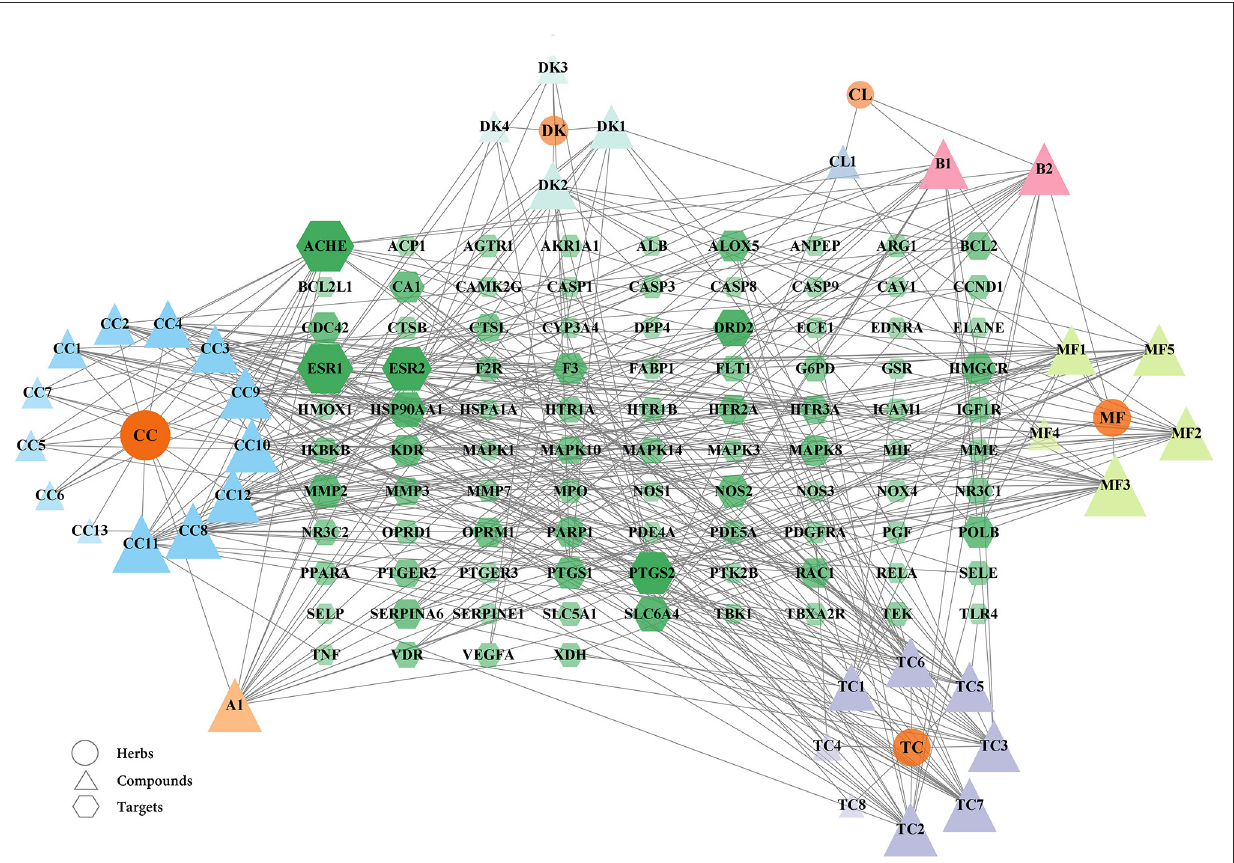
FIGURE3 The herb-compound-disease target network. The ellipse nodes, the triangle nodes, and the hexagon nodes represent the herbs, compounds, and targets, respectively. The connections represent the interactions among the three. The node size and color are related to the degree value. The larger the node area and the darker the color in the figure, the more important it is in the network.